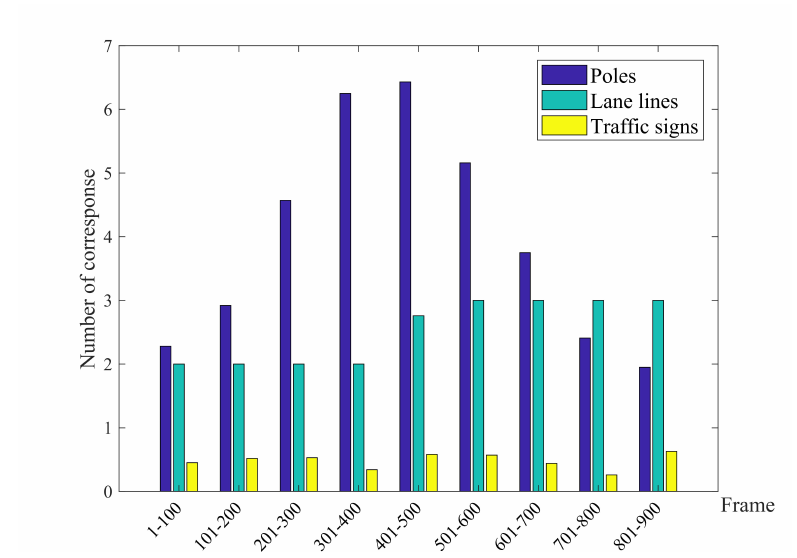
Figure 8. Corresponding road features for every 100 frames.